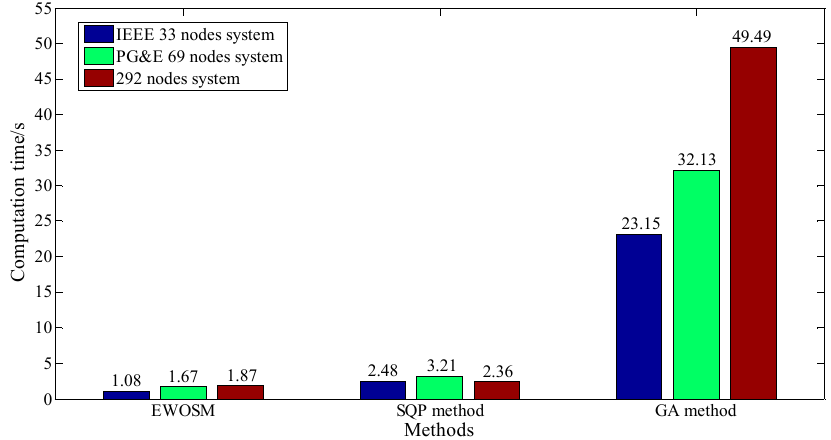
Figure 9. The comparison of computation time with three methods in different scale distribution networks.